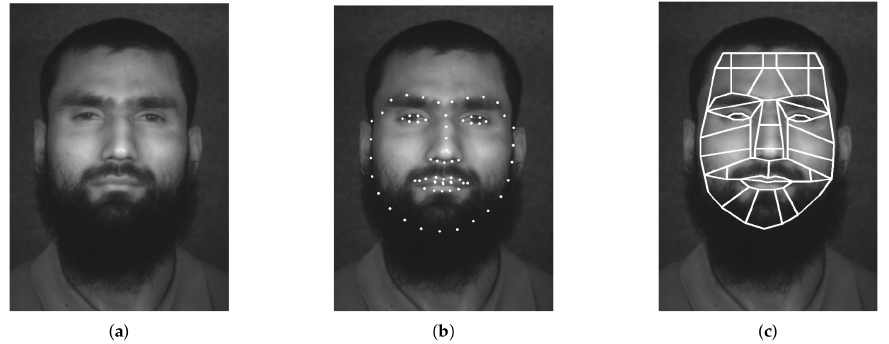
Figure 3. Extracting facial regions of interest from facial landmarks. ( a ) Base image. ( b ) Facial Landmarks. ( c ) Facial regions of